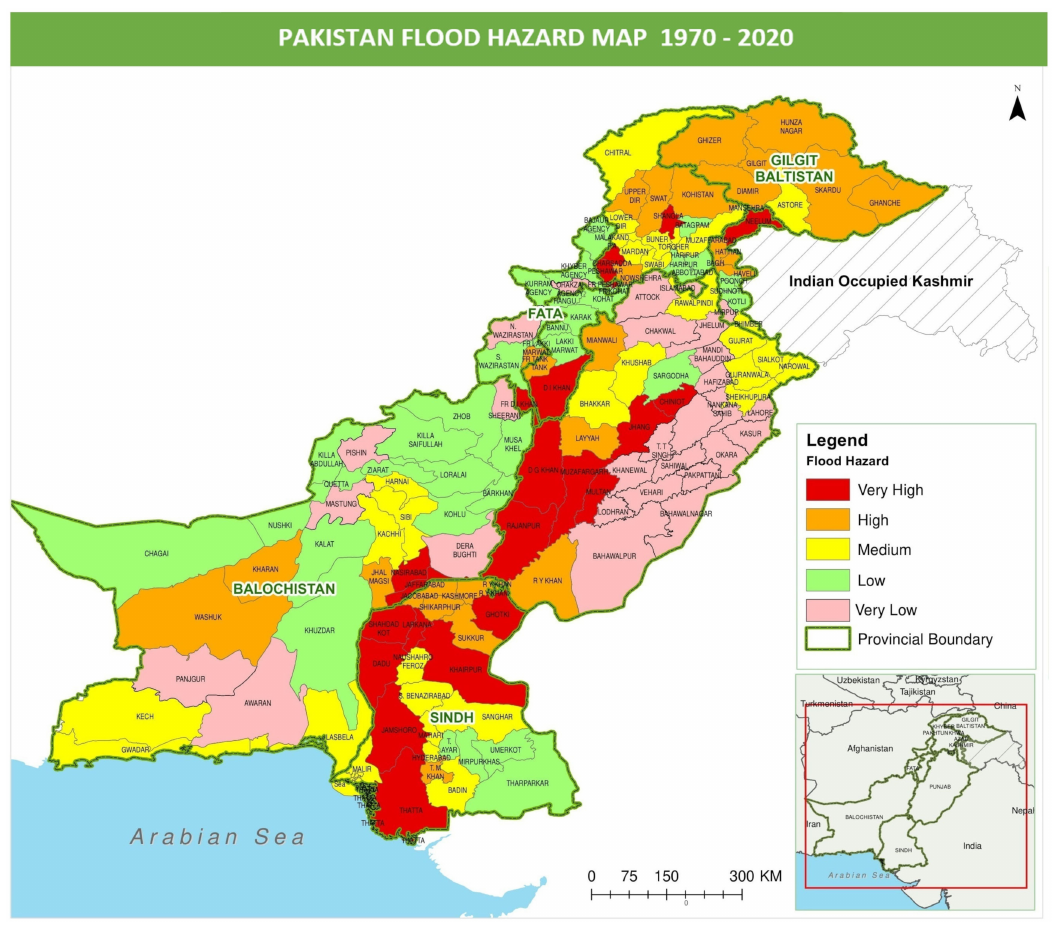
Figure 6. Pakistan Flood Hazard Map 1970–2020 showing intensity of flood at district